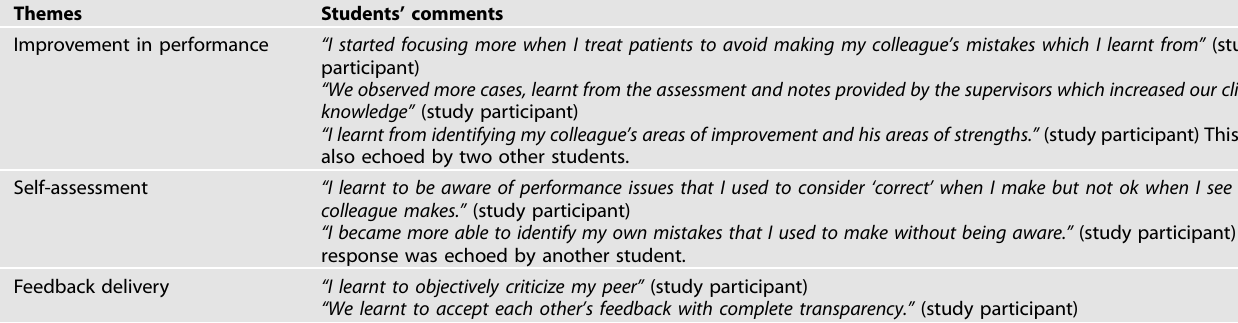
Table 4. Selected comments that pertain to each theme extracted from students ’ responses on the post-course questionnaire item “ What did you learn from peer-assessment? ”